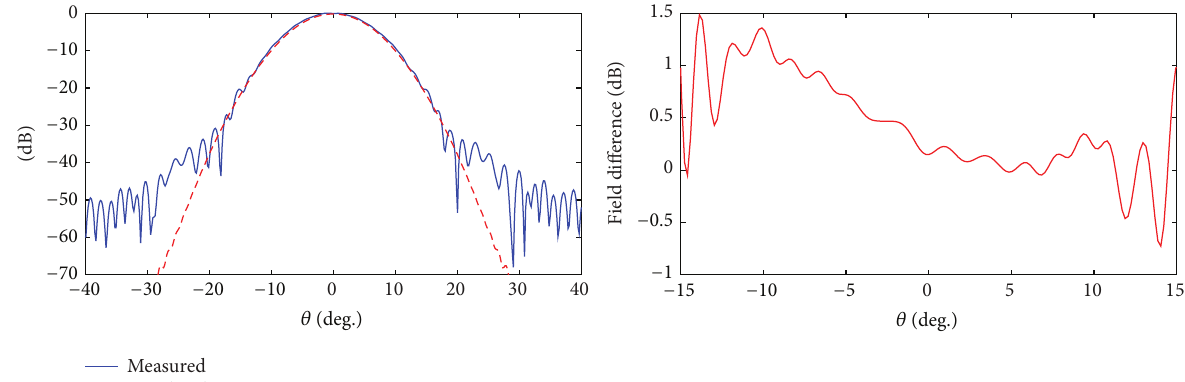
Figure 14: Calculated and simulated far field patterns of the 183 GHz channel on horizontal plane.